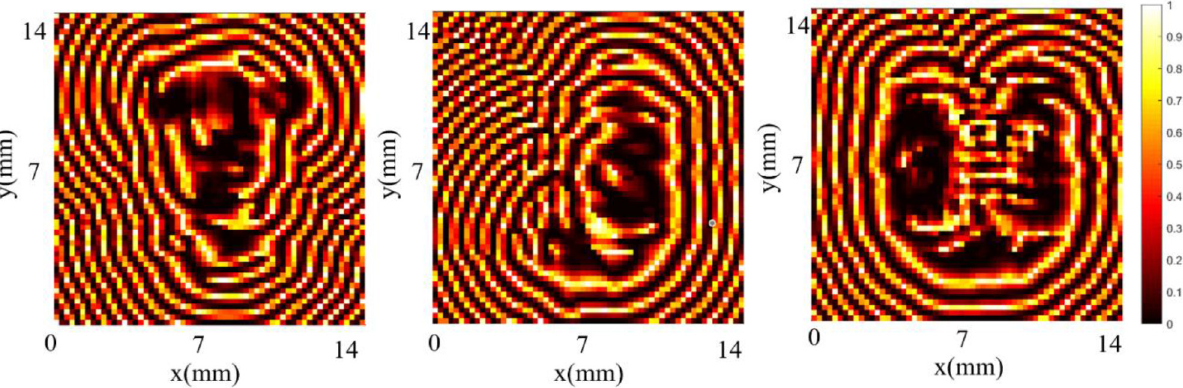
Fig. 9. The metasurface phase distribution of “ T ” , “ J ” and “ U ” .